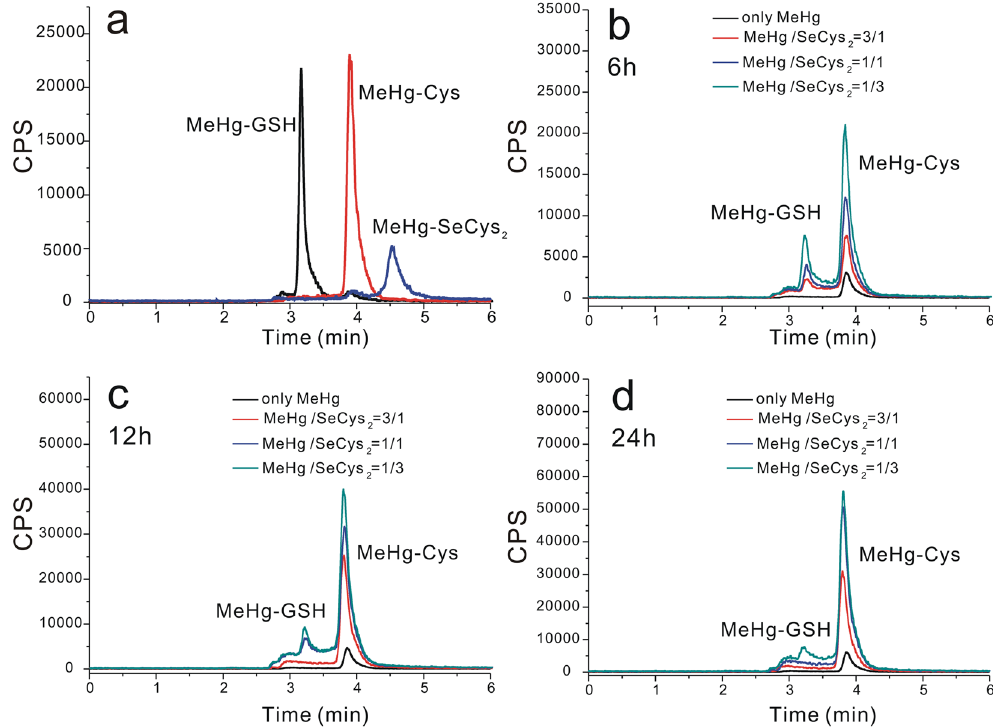
Figure 3. Chromatograms of mercury species obtained by RP-HPLC-ICP-MS in the standard solution of MeHg-GSH, MeHg-Cys and aggregation of MeHg and SeCys 2 , respectively ( a ) and in the cytosol of cells incubated with MeHg, and co-incubation with MeHg and SeCys 2 at the ratios of 3:1, 1:1, 1:3 for 6 h ( b ), 12 h ( c ), 24 h ( d ),